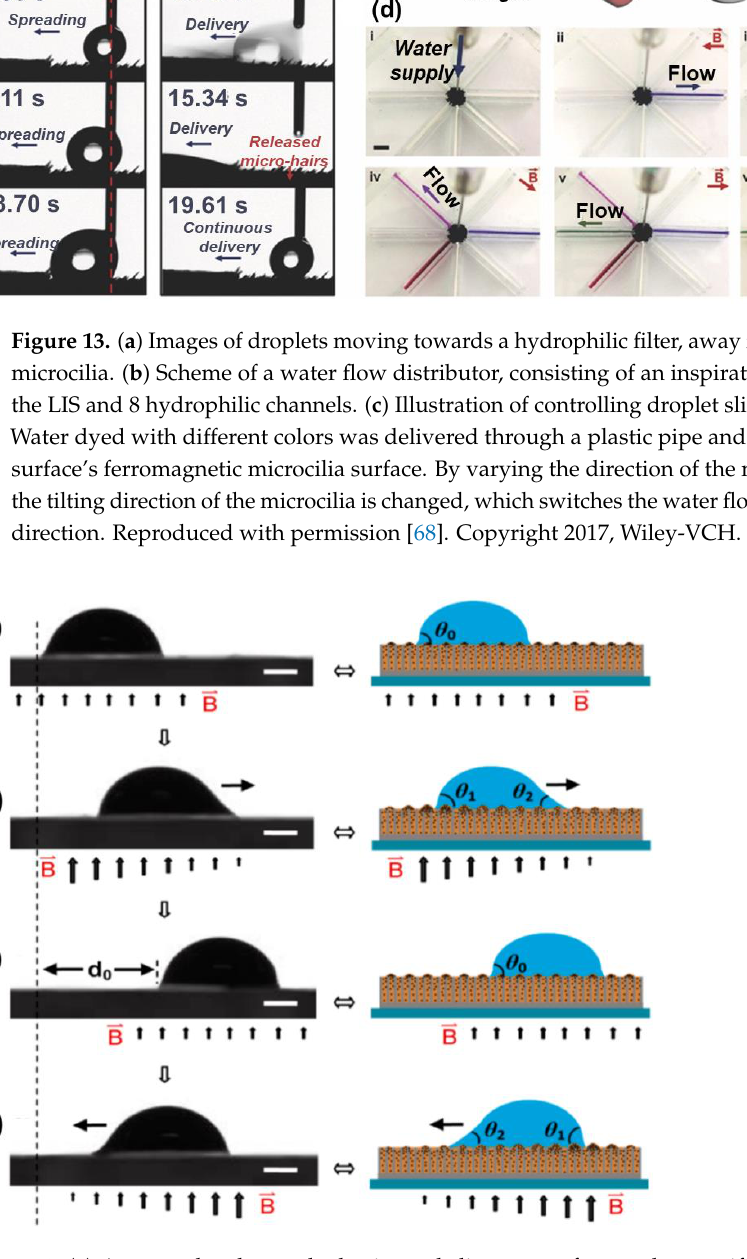
Figure 14. ( a ) A water droplet on the horizontal slippery surface under a uniform magnetic field. ( b ) The roughness gradient on the substrate surface induced by a gradient of the magnetic field results in the asymmetric deformation of the droplet. An unbalanced force caused by the roughness gradient drives the droplet to move. ( c ) The gradient magnetic intensity is transformed to a uniform one, so the droplet is pinned. ( d ) Applying an opposite-direction gradient magnetic field allows the droplet to move back. The water droplet size is ∼ 5 µ L. The bars in ( a – d ) are 500 µ m. Reprinted with permission from [66]. Copyright (2016) American Chemical